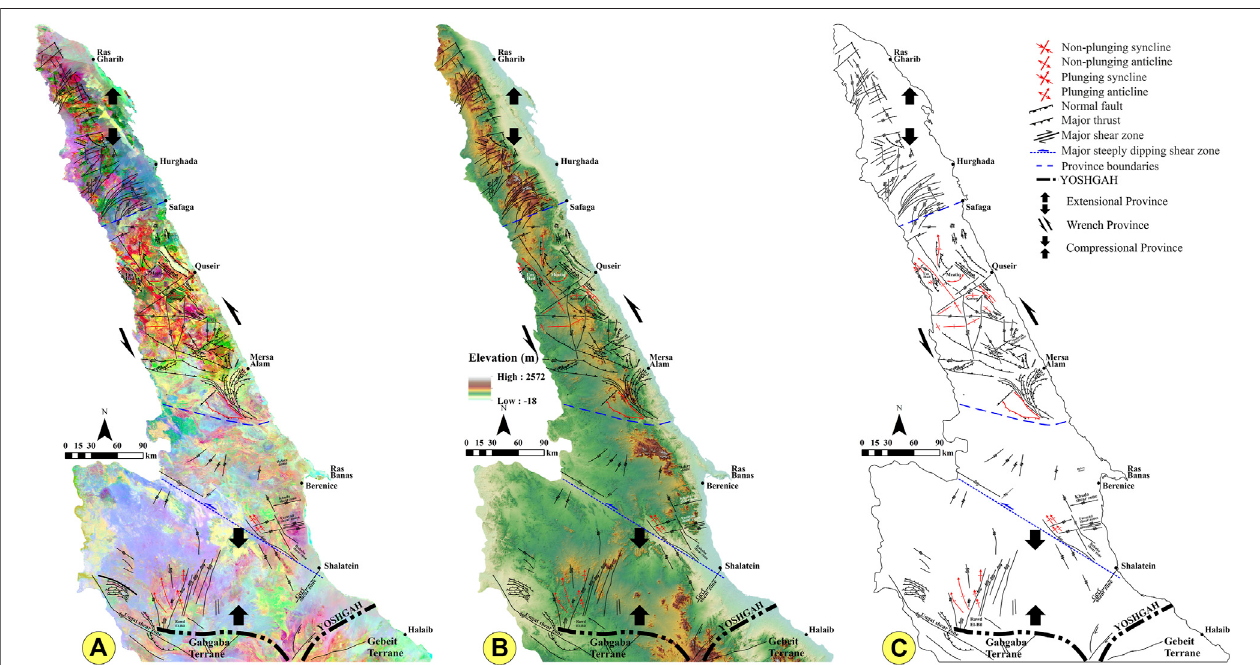
FIGURE 7 | Structural mapping promoted using the processing of Landsat-8 data, Digital Elevation Model (SRTM DEM), and Shaded relief map. The deduced structural elements are draped over (A) The landsat-8 band ratio, BR RGB (6/5, 6/7, 4/2), (B) SRTM DEM with the 30-m resolution, and Gray topographic Shaded relief map. Thedelineated structuresarerepresentedwithoutabackgroundin (C) .Themajorstructuralregimesandtectonicprovinceswerededucedinthepresentstudyby the color variation in the processed Landsat, and elevation in DEM.